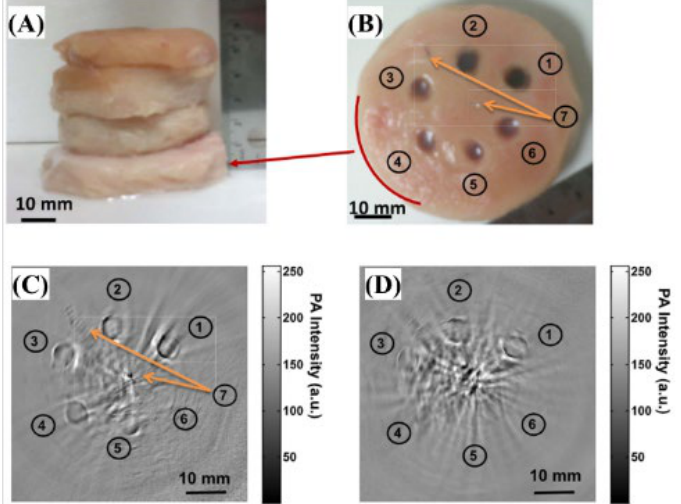
Figure 16. Comparison of deep embedded objects and their photoacoustic images. Photograph of ( A ) chicken breast muscle blocks stacked, ( B ) cross-section of chicken breast muscle with copper sulfide nanoparticles; two-dimensional photoacoustic image at a depth of ( C ) ∼ 2.5 cm and ( D ) ∼ 5 cm. Reprinted from Ku et al . , ACS Nano. 2012; 6, 8: 7489–7496 [35], with permission of the Optical Society of America.